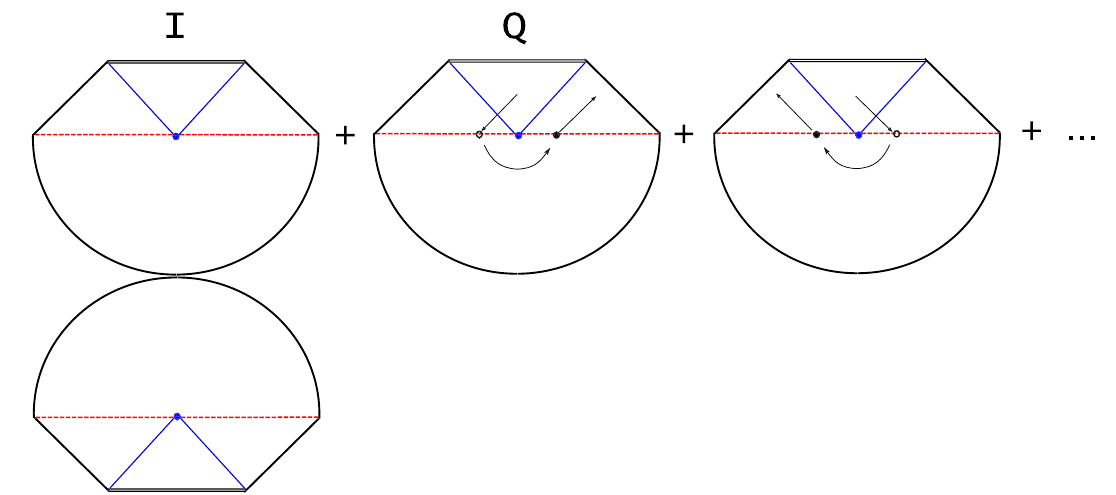
Fig. 4 As we sum over all instantons, I (Schwarzschild without scalar fields) corresponds the trivial process. There can be various instantons, but we only select instantons that has out-going modes, e.g., Q . If we sum I and Q , one can recover the Bogoliubov matrix at least in the heuristic